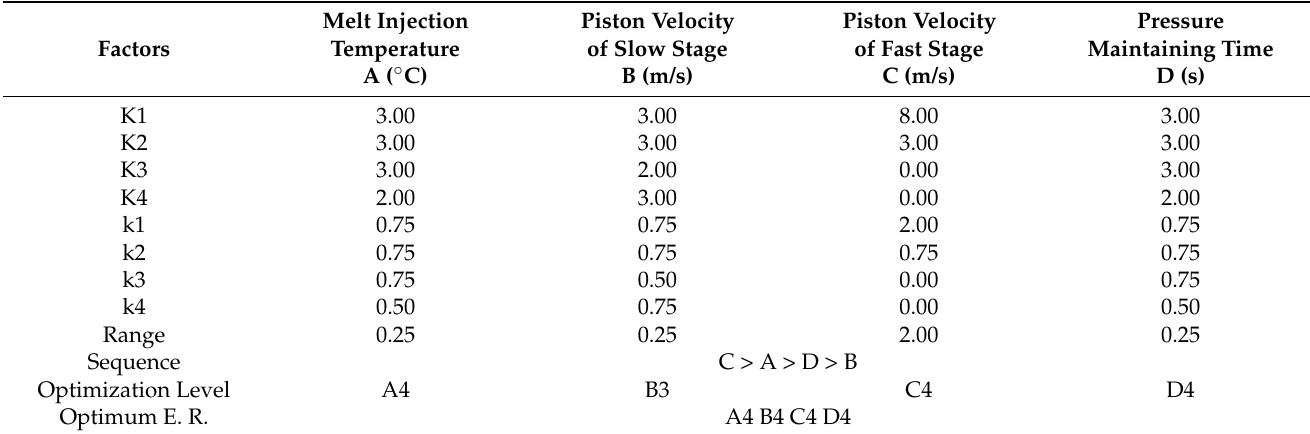
Figure 11. The typical scanning results of industrial CT (The red circle indicates the area of shrinkage porosity and the red rectangle indicates the area of gas porosity): ( a ) under the process conditions of test No. 1, ( b ) under the process conditions of test No. 2, ( c ) under the process conditions of test No. 3 and ( d ) under the process conditions of test No. 10. Table 6. Table of shrinkage porosity by means of range